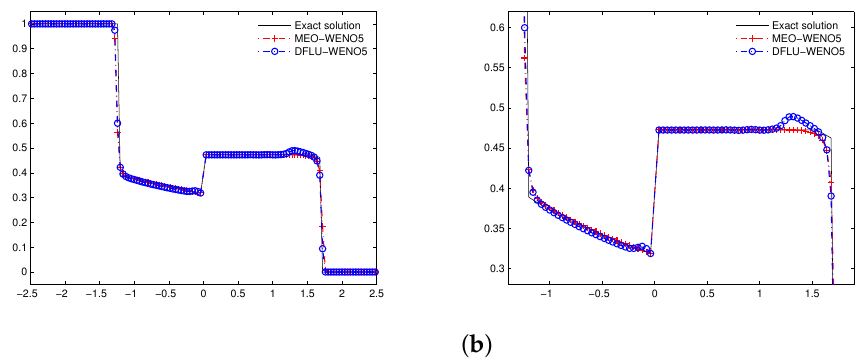
Figure 12. Example 3 computed by the MEO-WENO5 and DFLU-WENO5 with ∆ x = 1/25. ( a ): the numerical and exact solutions; ( b ): the numerical and exact solutions zoomed in.